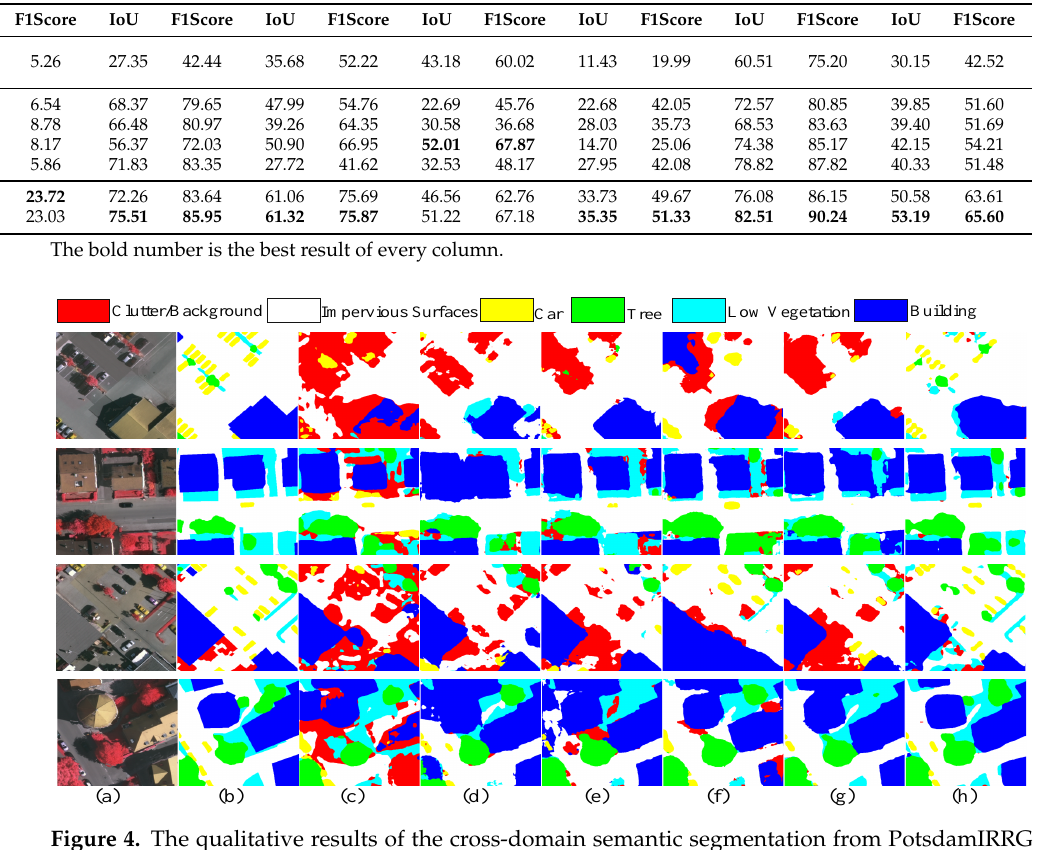
Figure 4. The qualitative results of the cross-domain semantic segmentation from PotsdamIRRG to Vaihingen. ( a ) Target images. ( b ) Labels. ( c ) Baseline (DeeplabV3 [43]). ( d ) Benjdira’s [26]. ( e ) DualGAN [33]. ( f ) AdaptSegNet [18]. ( g ) MUCSS [12]. ( h ) ResiDualGAN + OSA (ours).